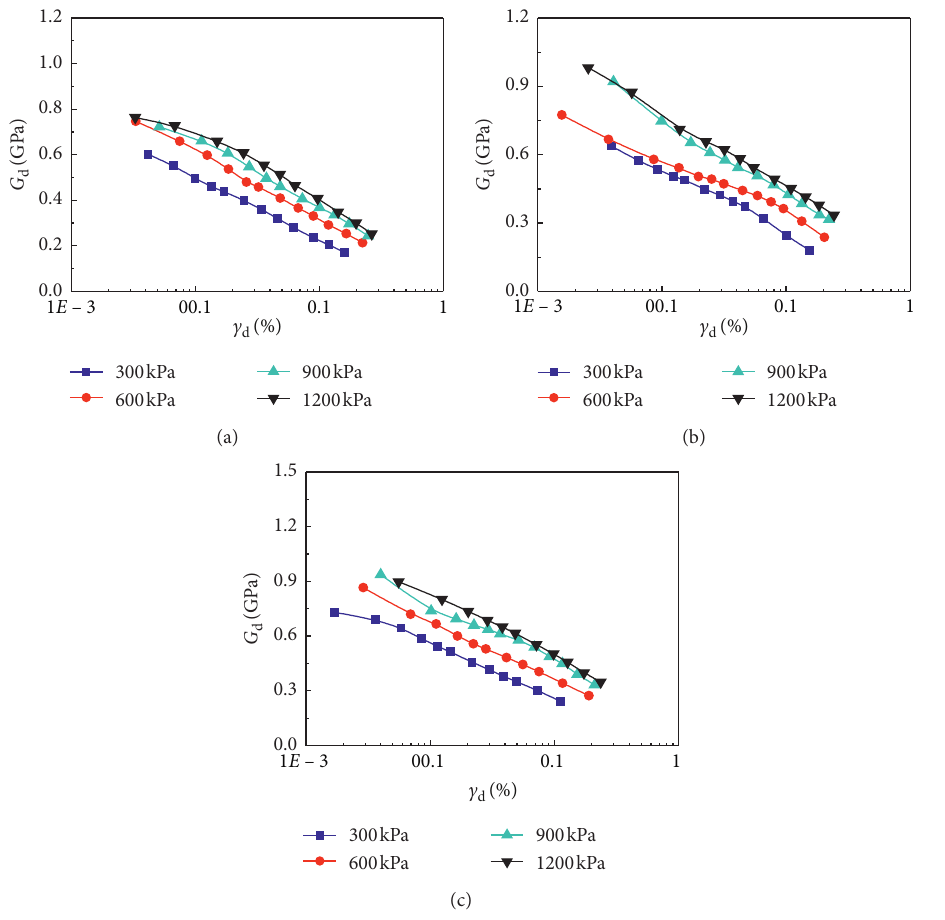
Figure 5: Shear modulus G d of the LCSG material under different cementing agent contents and according to changes in dynamic shear strain. (a) 40 kg/m 3 . (b) 60kg/m 3 . (c) 80 kg/m 3